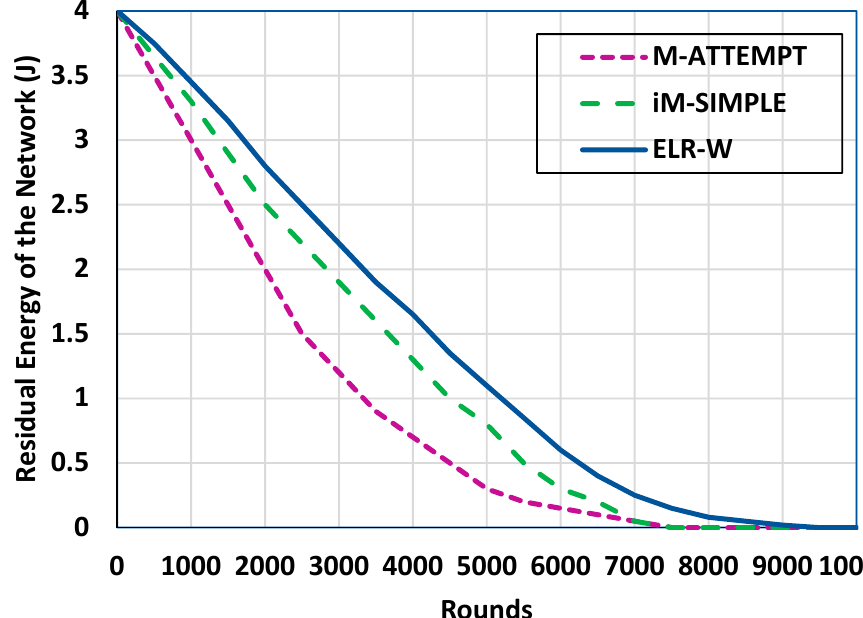
Figure 8. Analysis of energy consumption.